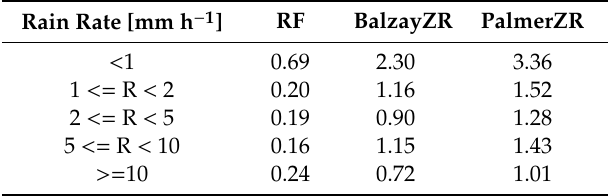
Table 5. Measurement errors for all rainfall retrieval models by considering di ff erent rain rate